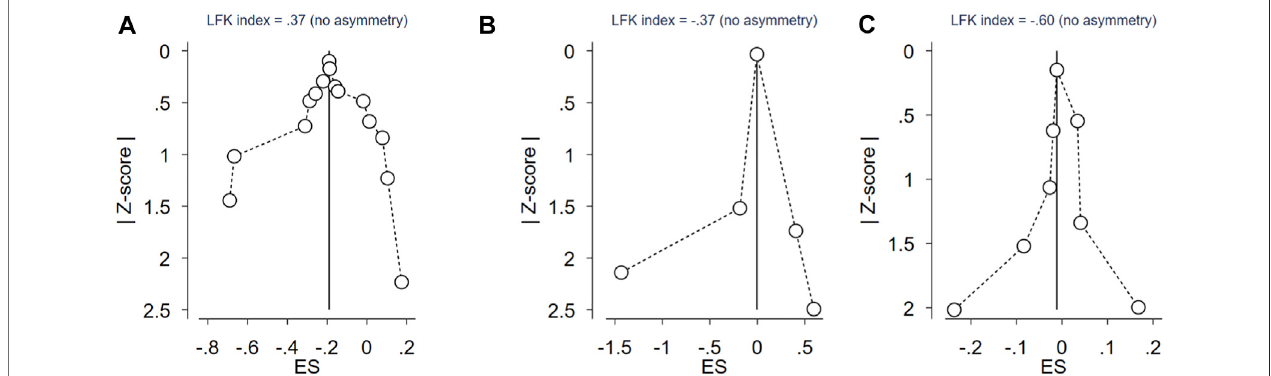
FIGURE 2 | Doi plot of rs743572 of CYP17 gene polymorphisms, rs2414096 of CYP19 gene polymorphisms, rs6529 of SHBG gene polymorphisms and PCOS risk. (A) Doi plot of rs743572 of CYP17 gene polymorphisms and PCOS risk; (B) Doi plot of rs2414096 of CYP19 gene polymorphisms and PCOS risk; (C) Doi plot of rs6529 of SHBG gene polymorphisms and PCOS